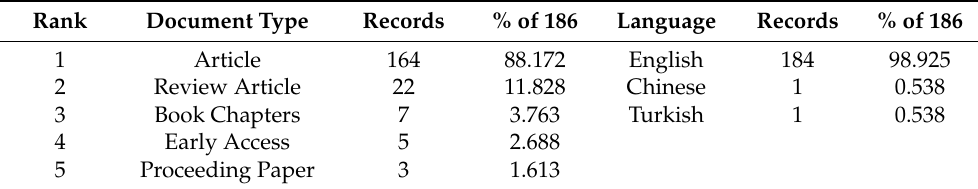
Table 1. Document types and languages of the publications on Web of Science concerning biodiesel production from essential